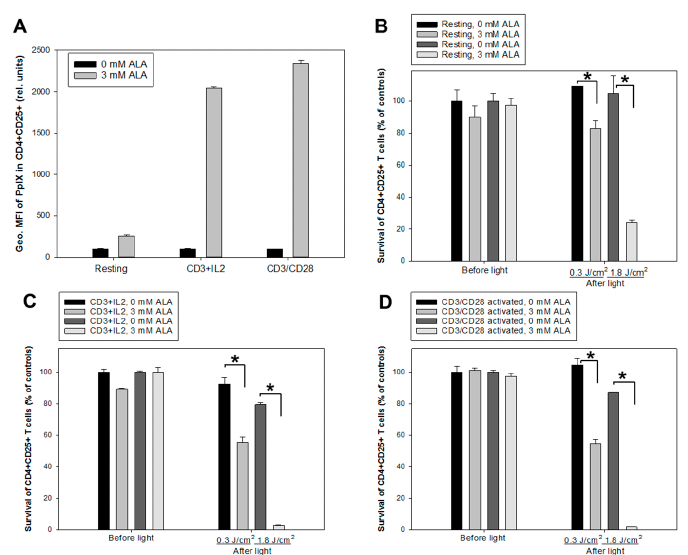
Figure 5. ALA-induced PpIX production and PDT of CD4 + CD25 + T cells. Healthy donor PBMCs were either activated in vitro with anti-CD3/IL-2 or anti-CD3/CD28 or kept non-activated (resting) for three days. ( A ) geometric mean fluorescence intensity (Geo. MFI) of PpIX in CD4 + CD25 + cells incubated